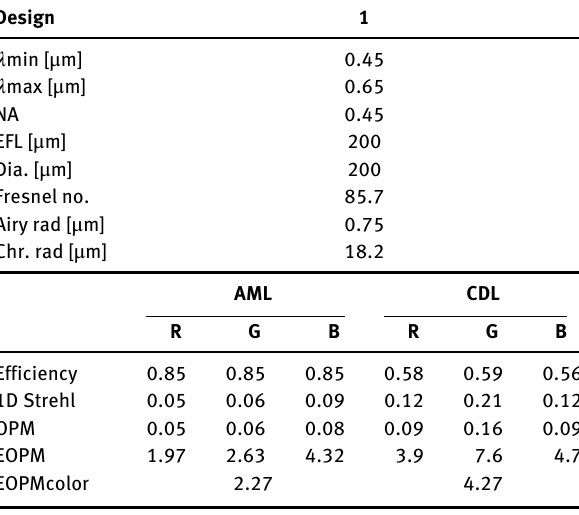
Table 4: Comparison of achromatic metalens (AML) based on EDOF lens of [9] to equivalent conventional diffractive lens